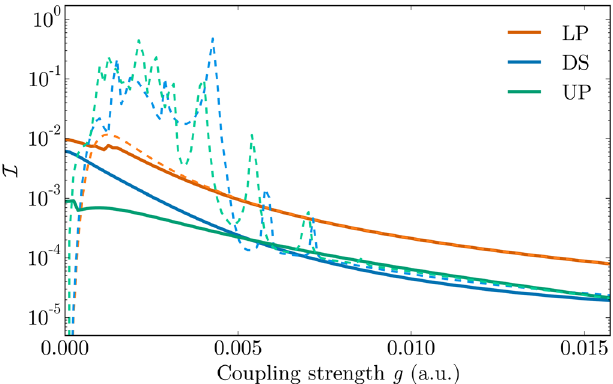
9. Solid lines: mutual information in the nuclear prop- ability distribution of the vibrational ground states of the coupled PES as predicted by Eq. (B2) using the values of β = α shown in Fig. 7. Dashed lines: mutual information in the nuclear proba- bility distribution of the steady state under driving of a single molecule, Eq.